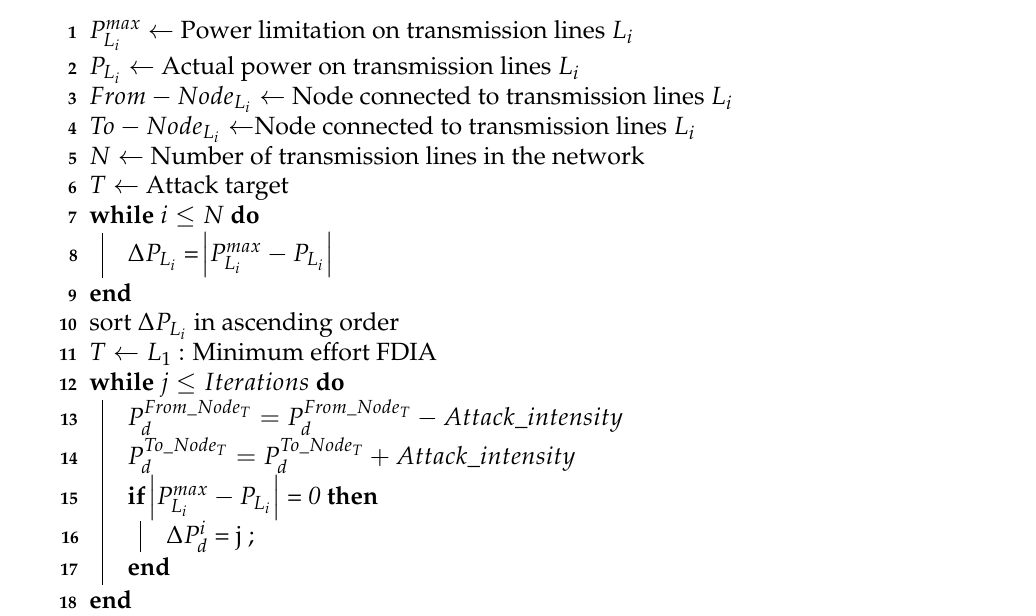
Algorithm 2: Minimum effort attack algorithm